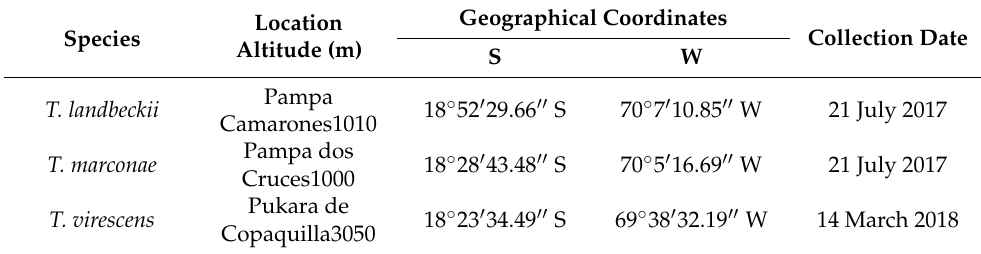
Table 3. Location of Tillandsia landbeckii , T. marconae , and T. virescens (Atacama Desert, Chile). Geographical Location Species Altitude (m)